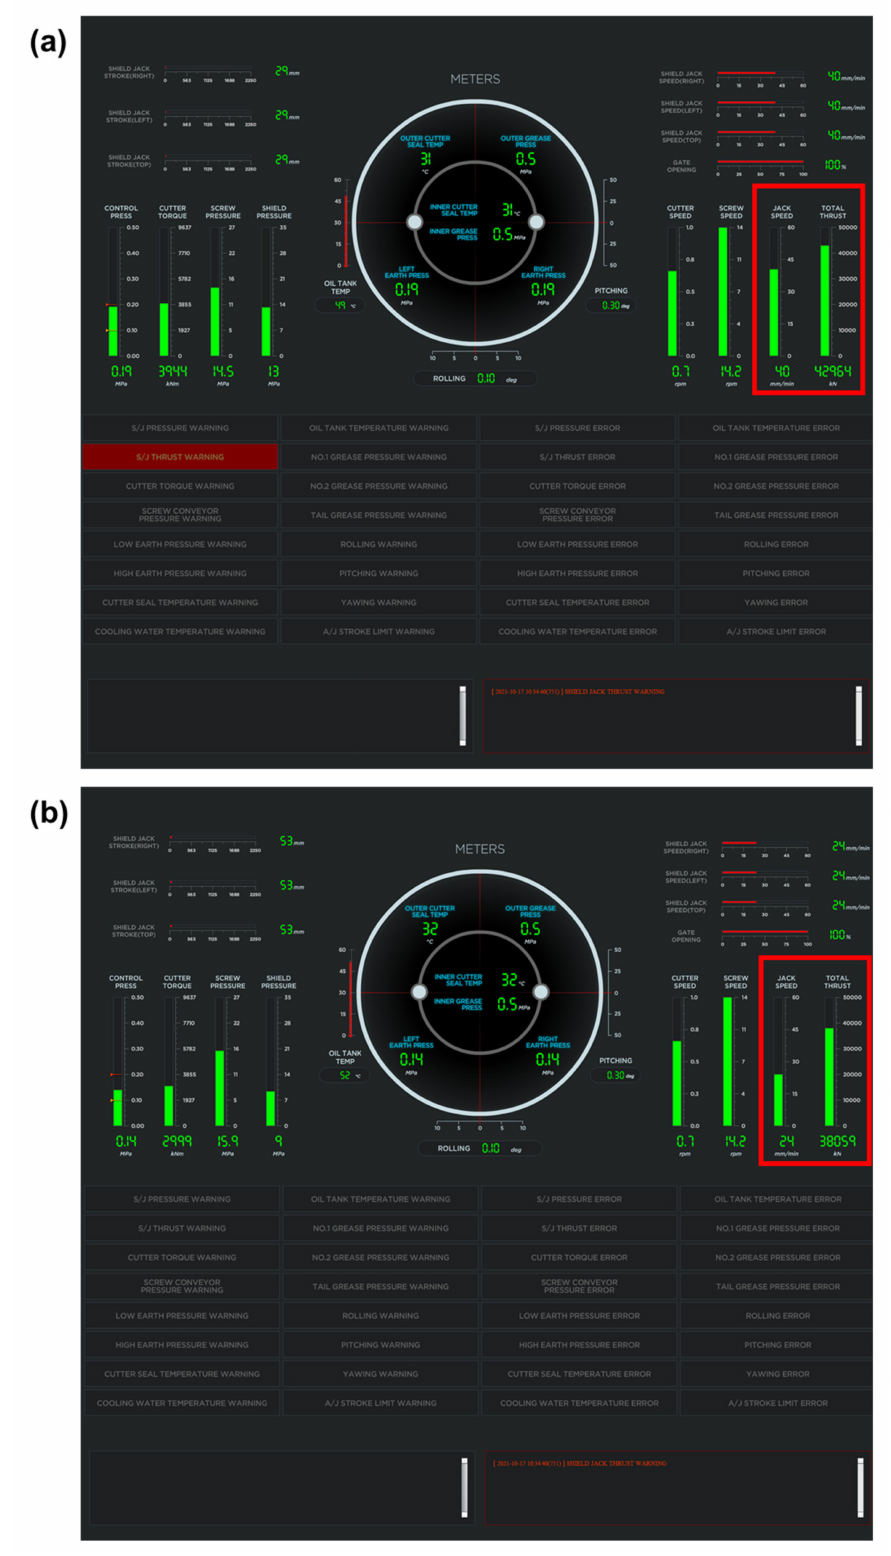
Figure 12. Simulation test results induced by: ( a ) thrust increase; and ( b ) shield jack speed decrease (refer to values in red